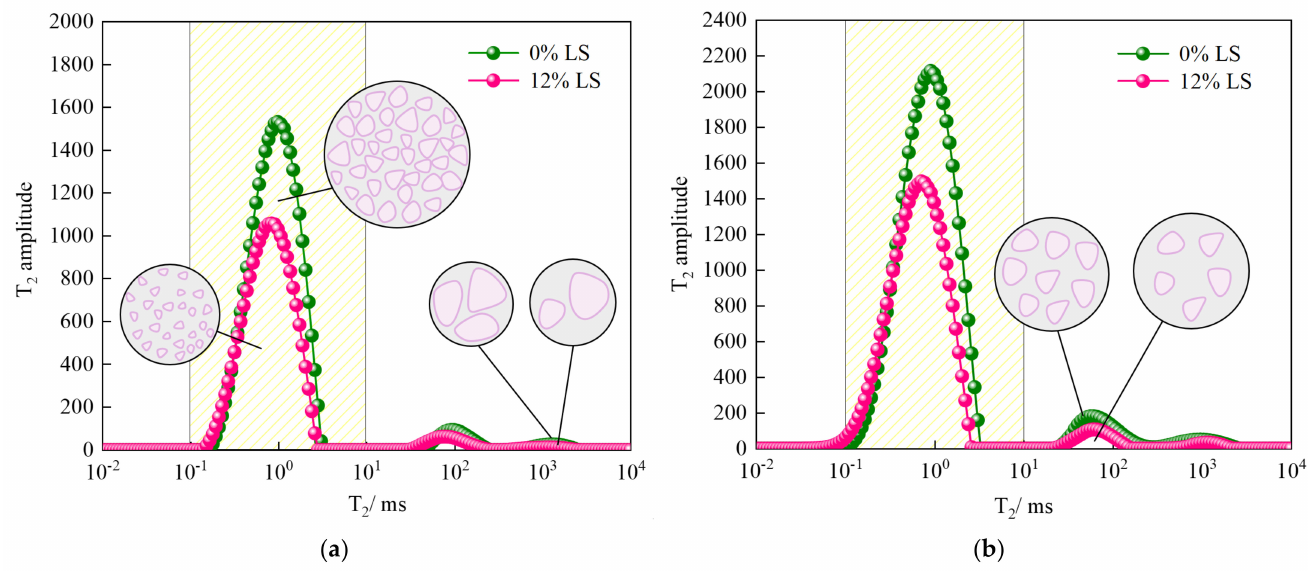
Figure 12. T 2 distributions of cement soil with freeze–thaw cycles times of 0 and 4 at different LS contents: ( a ) 0 freeze–thaw cycles and ( b ) 4 freeze–thaw